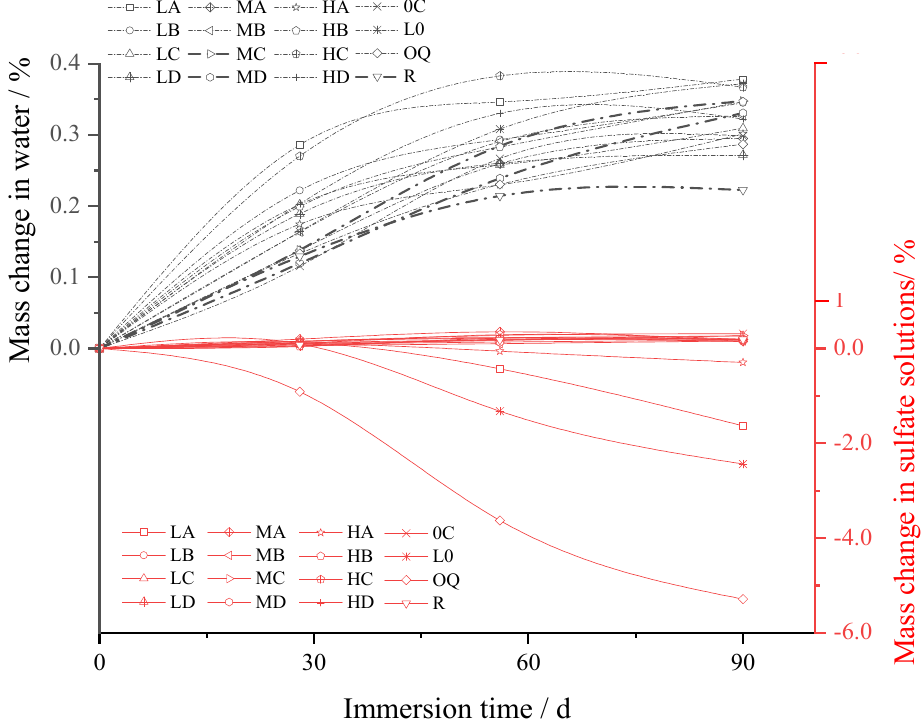
Figure 12. Mass change curve.